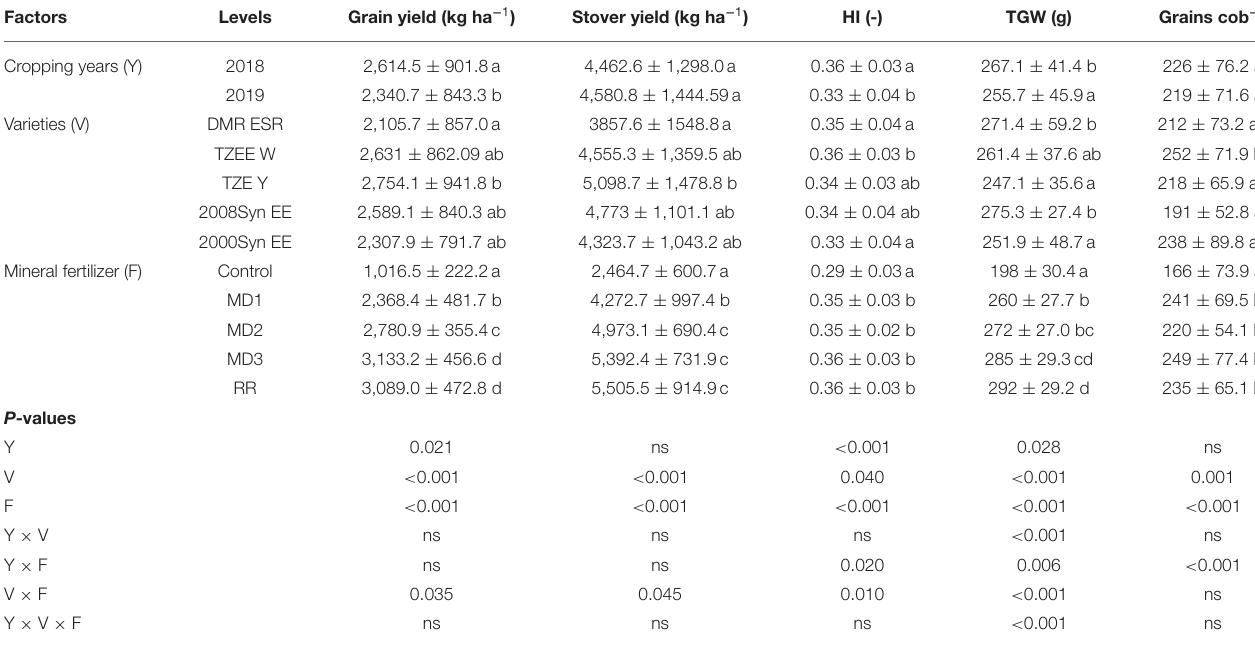
TABLE 3 | Grain yield and components (mean ± standard error) as affected by the cropping years, varieties and mineral fertilizer.